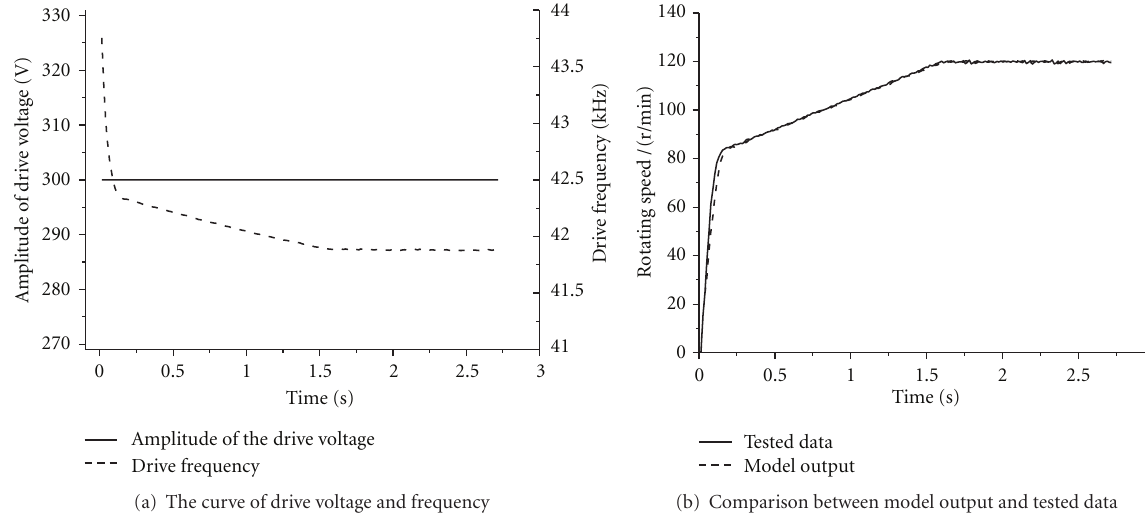
(b) Comparison between model output and tested data Figure 15: Slope response comparison between model output and tested data ( Ure f = 300 V, no